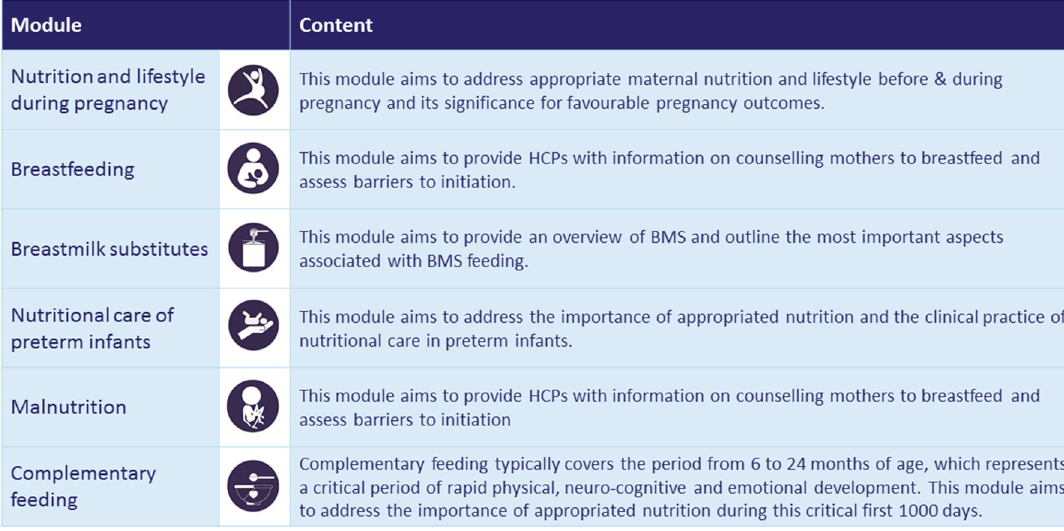
Figure 2. ENeA SEA e-learning modules and their content.